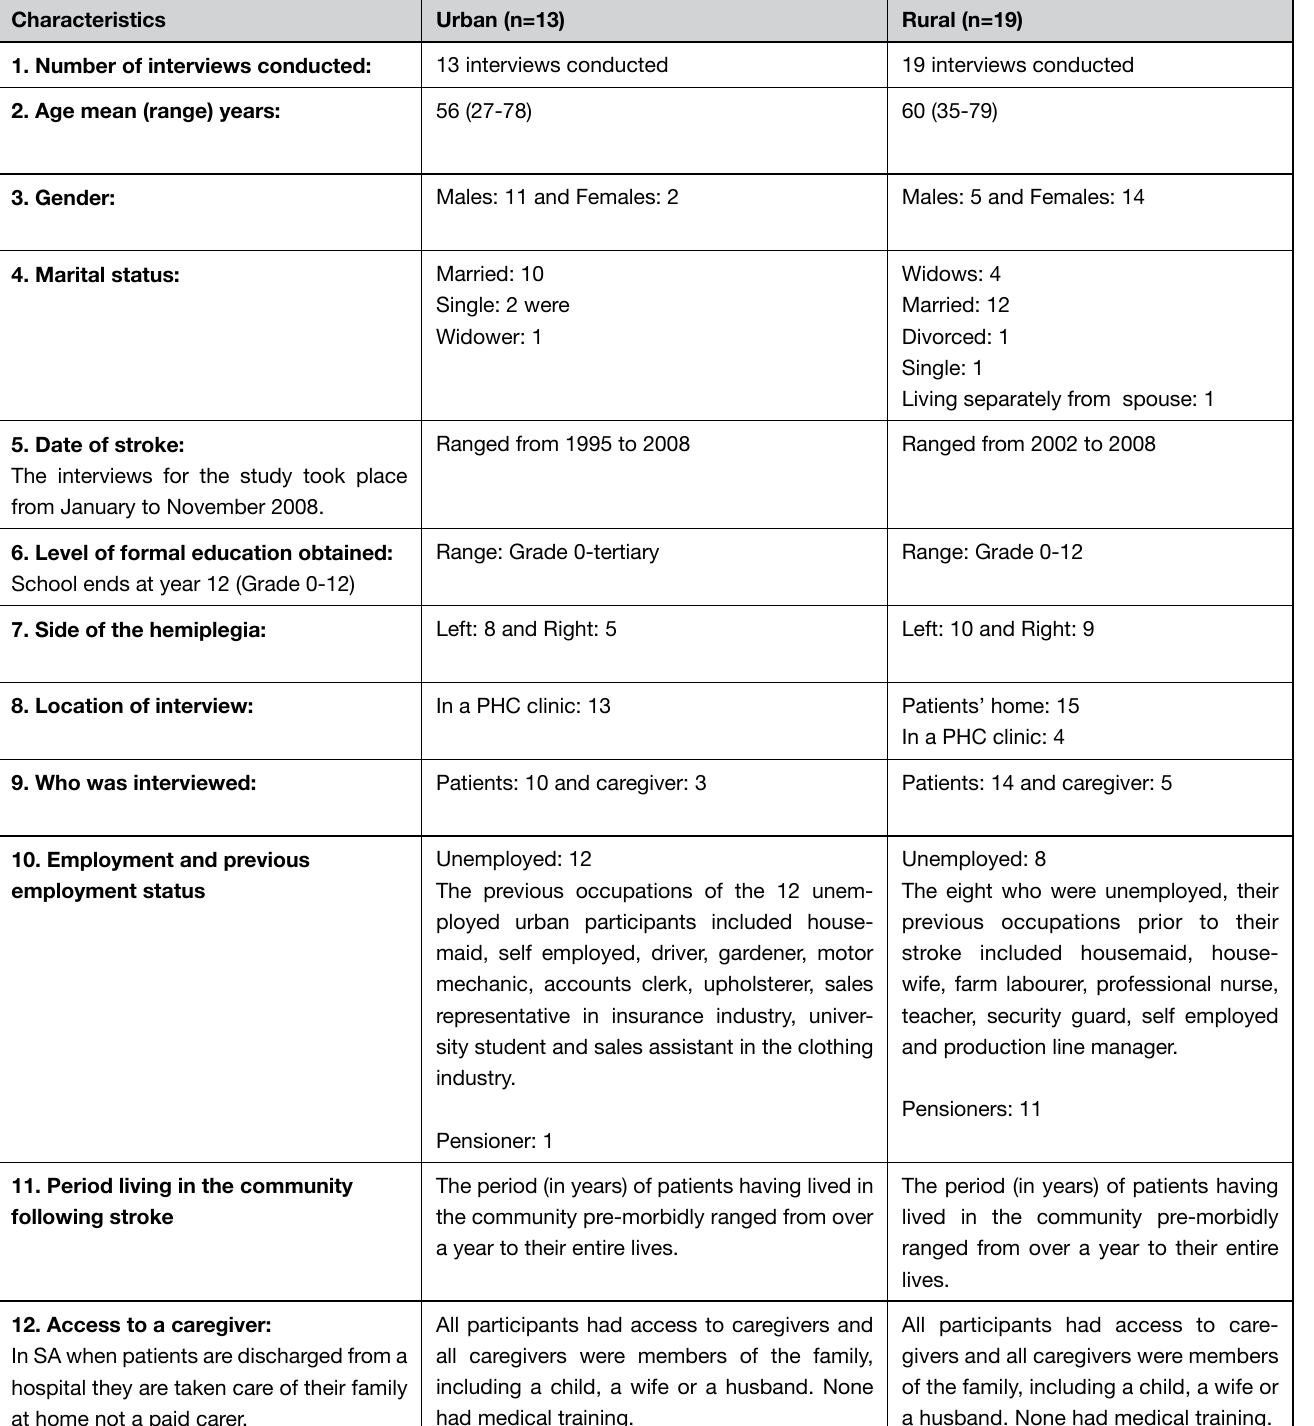
Table 1: demographic Characteristics of Participants